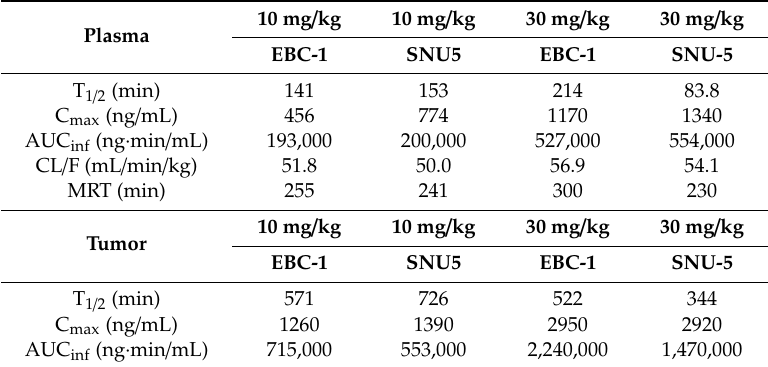
Figure 5. Pharmacokinetic / Pharmacodynamic correlation of ABN401. Quantitative analysis of ABN401 in plasma and tumor tissues in ( A ) EBC-1 and ( B ) SNU-5 models. Based on the tumor to plasma ratio of the AUC inf value for ABN401 (AUC tumor / AUC plasma ), K p,ss values at a dose of 10 and 30 mg / kg of ABN401 were estimated. The dose and duration of ABN401 treatment required to inhibit c-MET phosphorylation were determined by immunohistochemistry (IHC) and Western blotting (WB) in ( C ) EBC-1 and ( D ) SNU-5 models. For analysis of the concentration–time relationship of PK / PD, data were integrated. Table 4. Quantitative Analysis of ABN401 in the plasma and tumor tissue in mice.